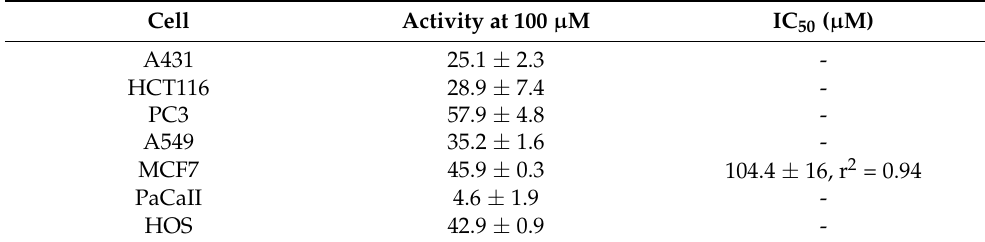
Figure 8. Cytotoxic activity of Pep-CuNCs at 100 µM. Table 2. Activity of Pep-CuNCs on different human tumor cell lines. Table 3. Activity of Pep-CuNCs on tumor cell lines.